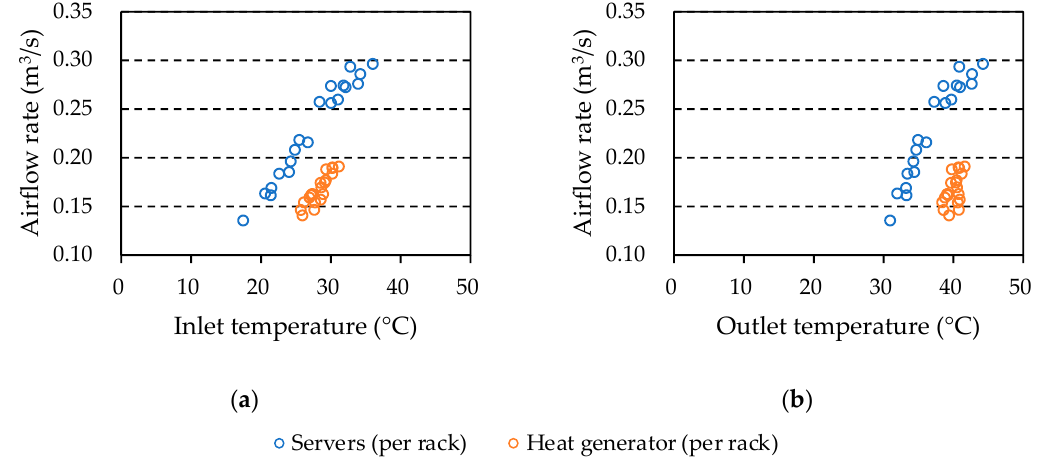
Figure 9. Relationship between ambient temperature and airflow rate of equipment per rack (“server” represents results of experiment B; “heat generator” represents results of experiments C and D): ( a ) Inlet temperature and airflow rate and ( b ) outlet temperature and airflow rate.